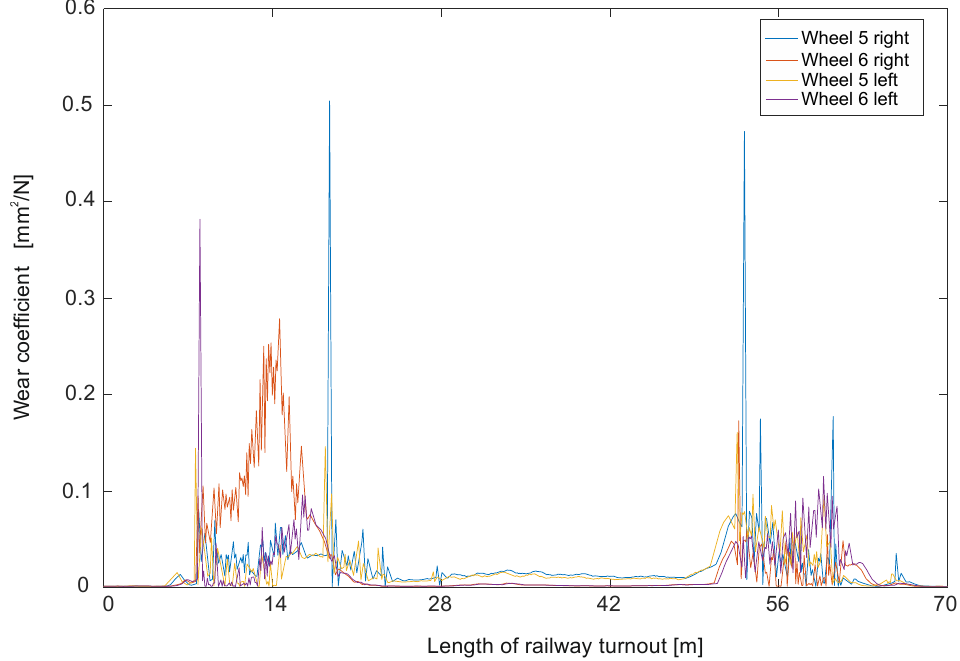
Figure 32. Wear coefficient obtained for a straight track with a turnout at 250 km/h .